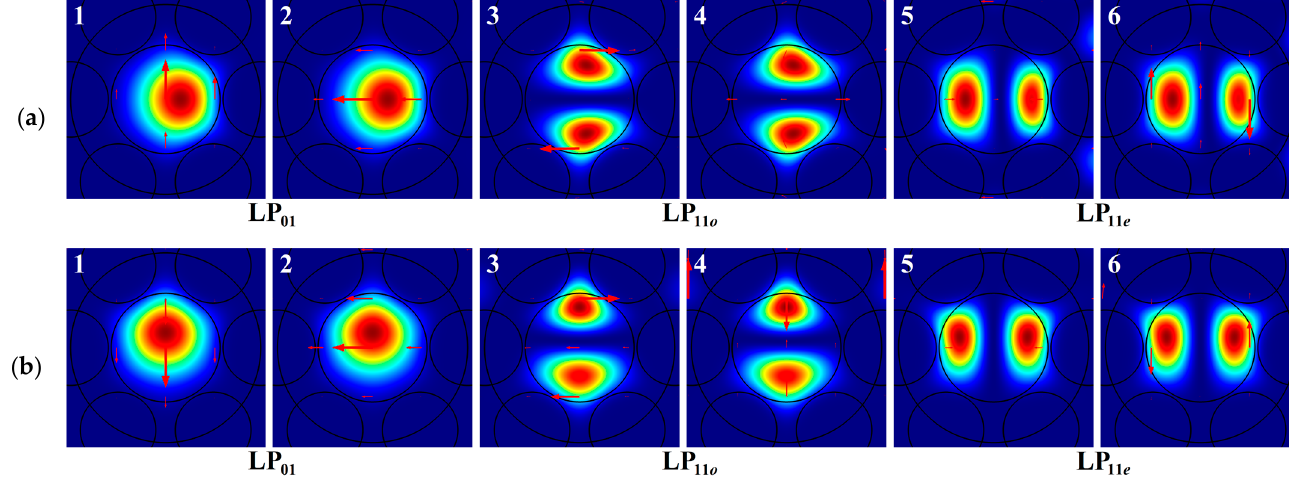
Figure 6. Spatial intensity distributions of (1, 2) fundamental modes and (3–6) higher-order modes in the bent MOF-18 at a wavelength of 0.85 µm for bending radii: ( a ) R x = 0.08 m and ( b ) R y = 0.08 m.